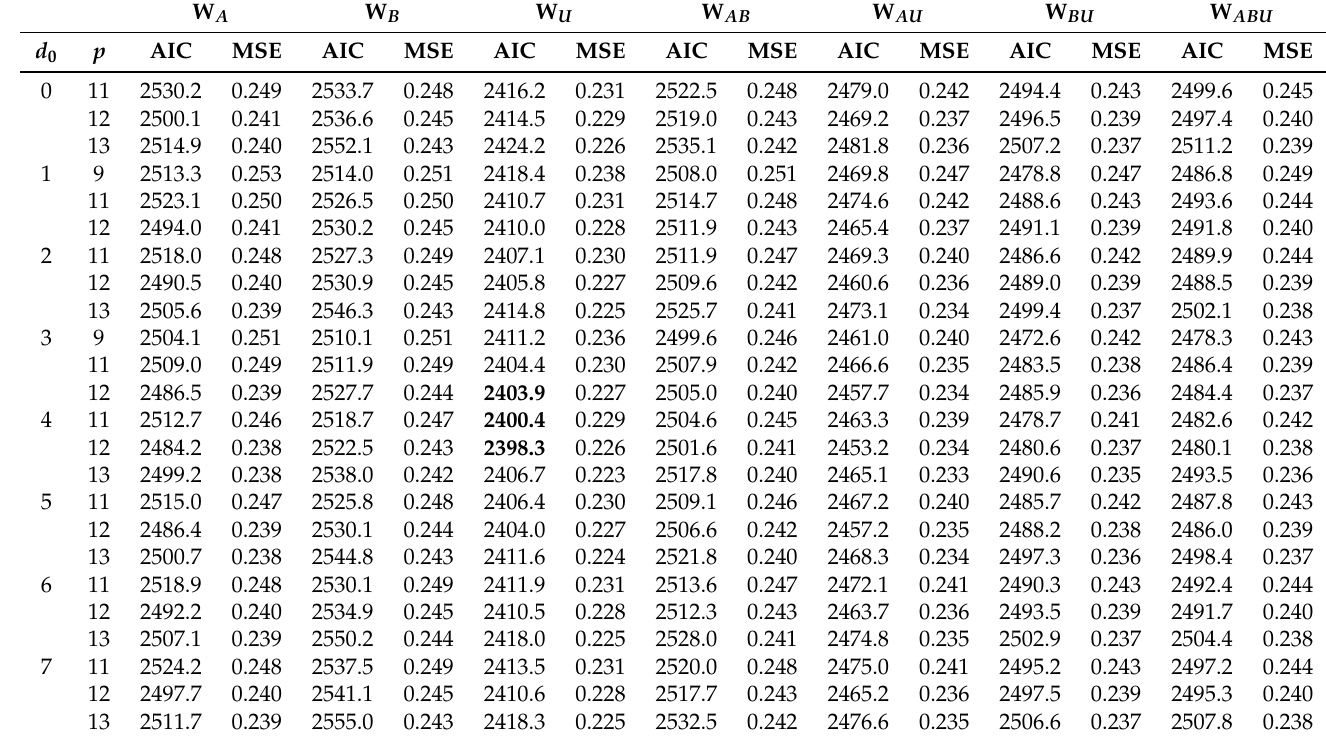
Table 2. Selected list of AIC and MSE values under various combinations of p and d 0 using different weight matrices. For each value of d 0 , the values of p that resulted in the lowest three AIC values under W U are provided. The overall lowest three values of AIC were indicated by boldface. Full results are provided in Online Supplementary File